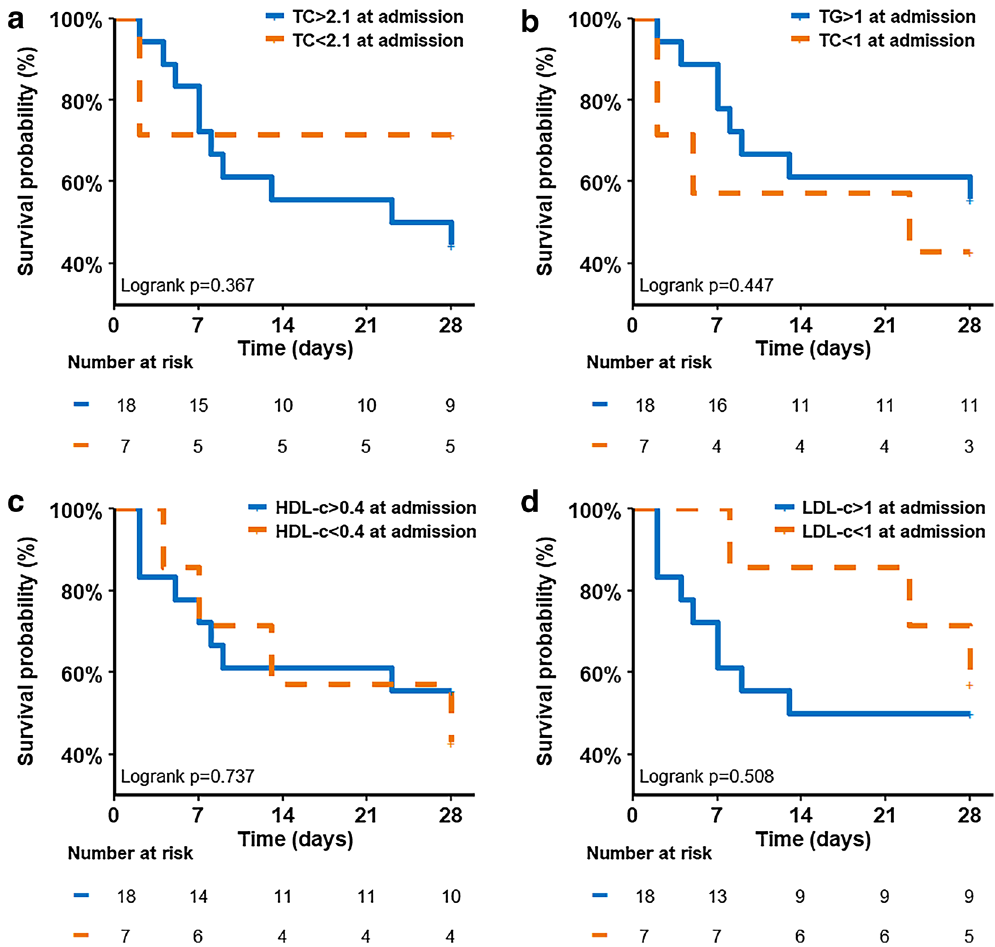
Figure 3. Mortality at day 28 according to the lipid value at admission estimated with Kaplan–Meier analyses and compared by the log-rank test. ( a ) Total Cholesterol (TC). The value of 2.1 mmol/l represents the cut-off to define the first quartile of patient according to TC at admission (< 2.1 mmol /l). ( b ) Triglycerides (TG). The value of 1 mmol/l represents the cut-off to define the first quartile of patient according to TG at admission (< 1 mmol /l). ( c ) High-density lipoproteins cholesterol (HDL-C). The value of 0.4 mmol/l represents the cut off to define the first quartile of patient according to HDL-c at admission (< 0.4 mmol /l) and ( d ) Low-density lipoproteins cholesterol (LDL-C). The value of 1 mmol/l represents the cut-off to define the first quartile of patient according to LDL-C at admission (< 1 mmol /l).